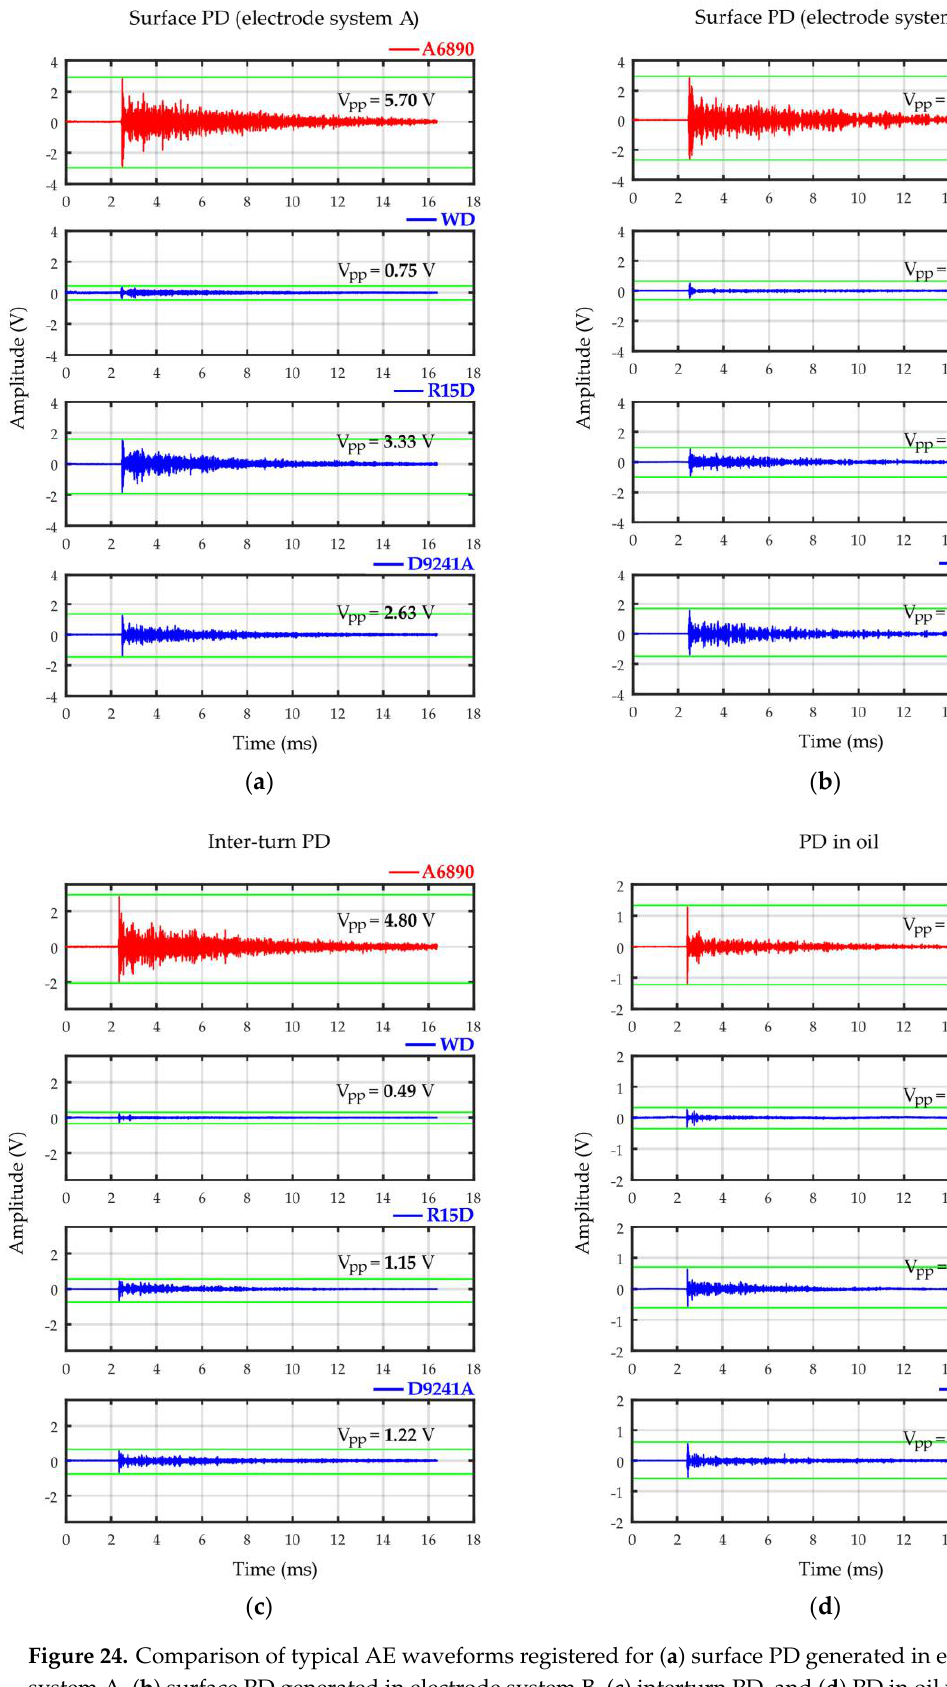
Figure 24. Comparison of typical AE waveforms registered for ( a ) surface PD generated in electrode system A, ( b ) surface PD generated in electrode system B, ( c ) interturn PD, and ( d ) PD in oil with the use of prototype (A6890) and commercial AE sensors (PAC WD, PAC R15D, and PAC D9241A).